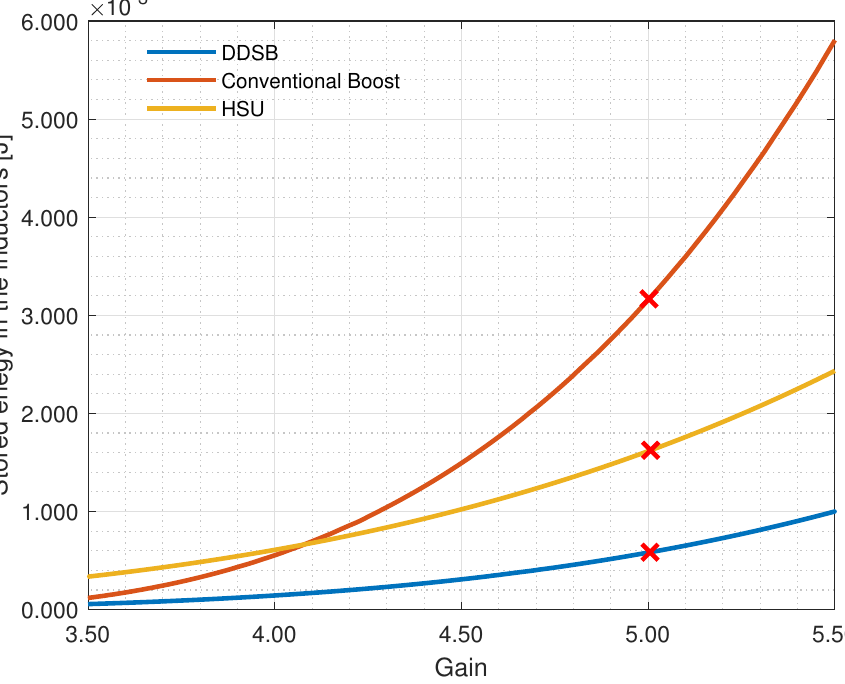
Figure 10. Stored energy in the inductors of the conventional boost and HSU vs. DDSB power converters with respect to the gain